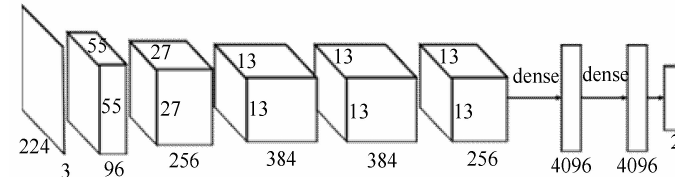
Figure 8. AlexNet architecture.